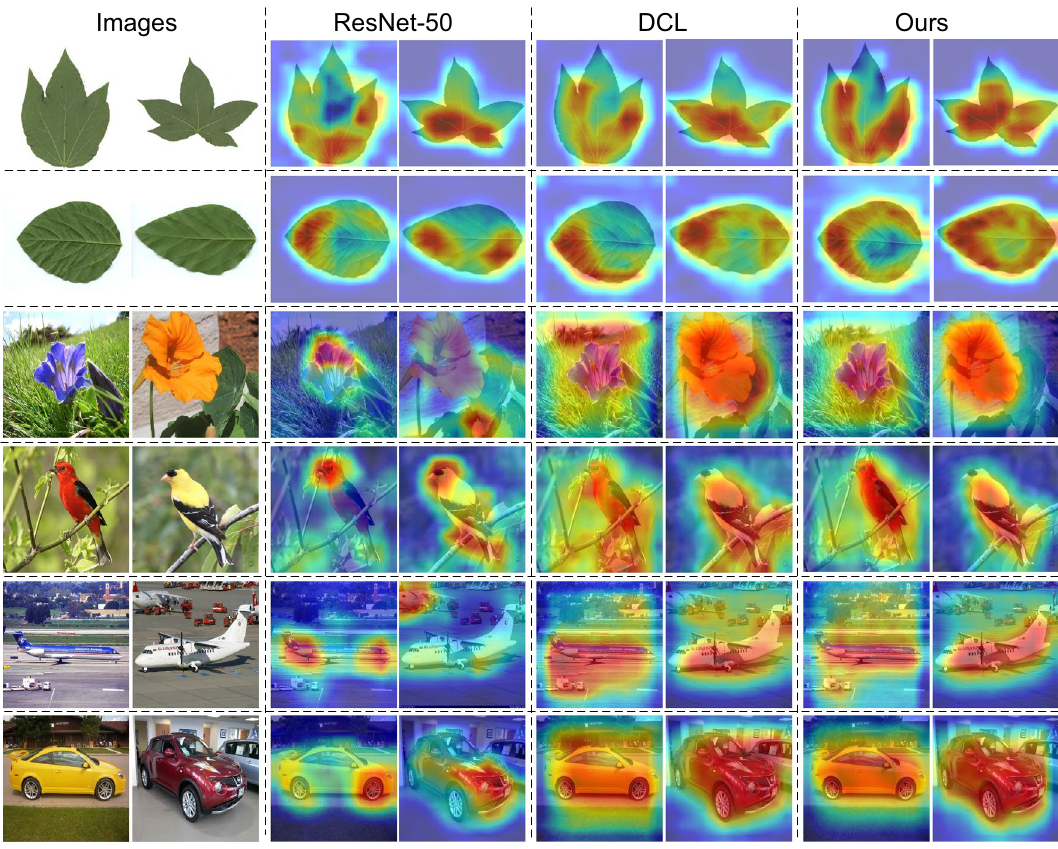
Figure 6. Feature map visualization of our method and two other methods based on the last convolution layer of ResNet-50 backbone.